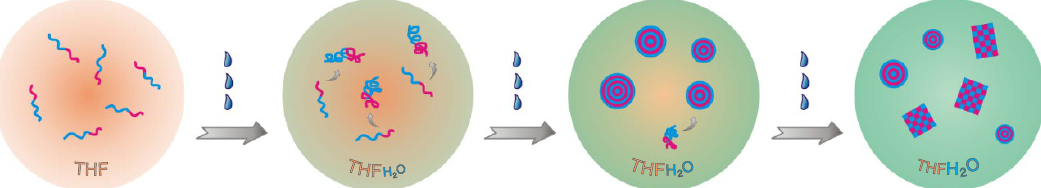
Figure 5 | Proposed self-assembling pathway. Schematic illustration of the self-assembly process of PAA- b -PIL in THF/H 2 O mixture with the addition of